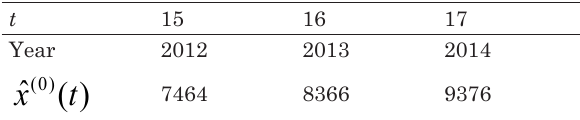
Table 3. Forecast value for affordable housing prices for period, t + 1